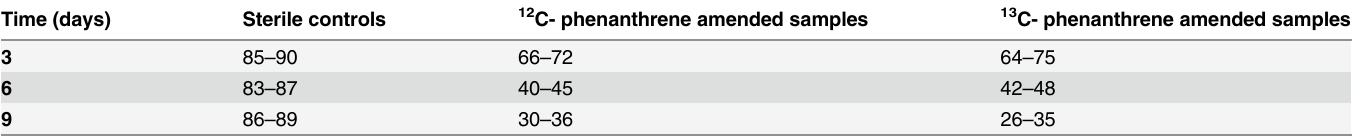
Table 1. Ranges for percentage of phenanthrene remaining in soil-liquid slurries over time. Time (days) Sterile